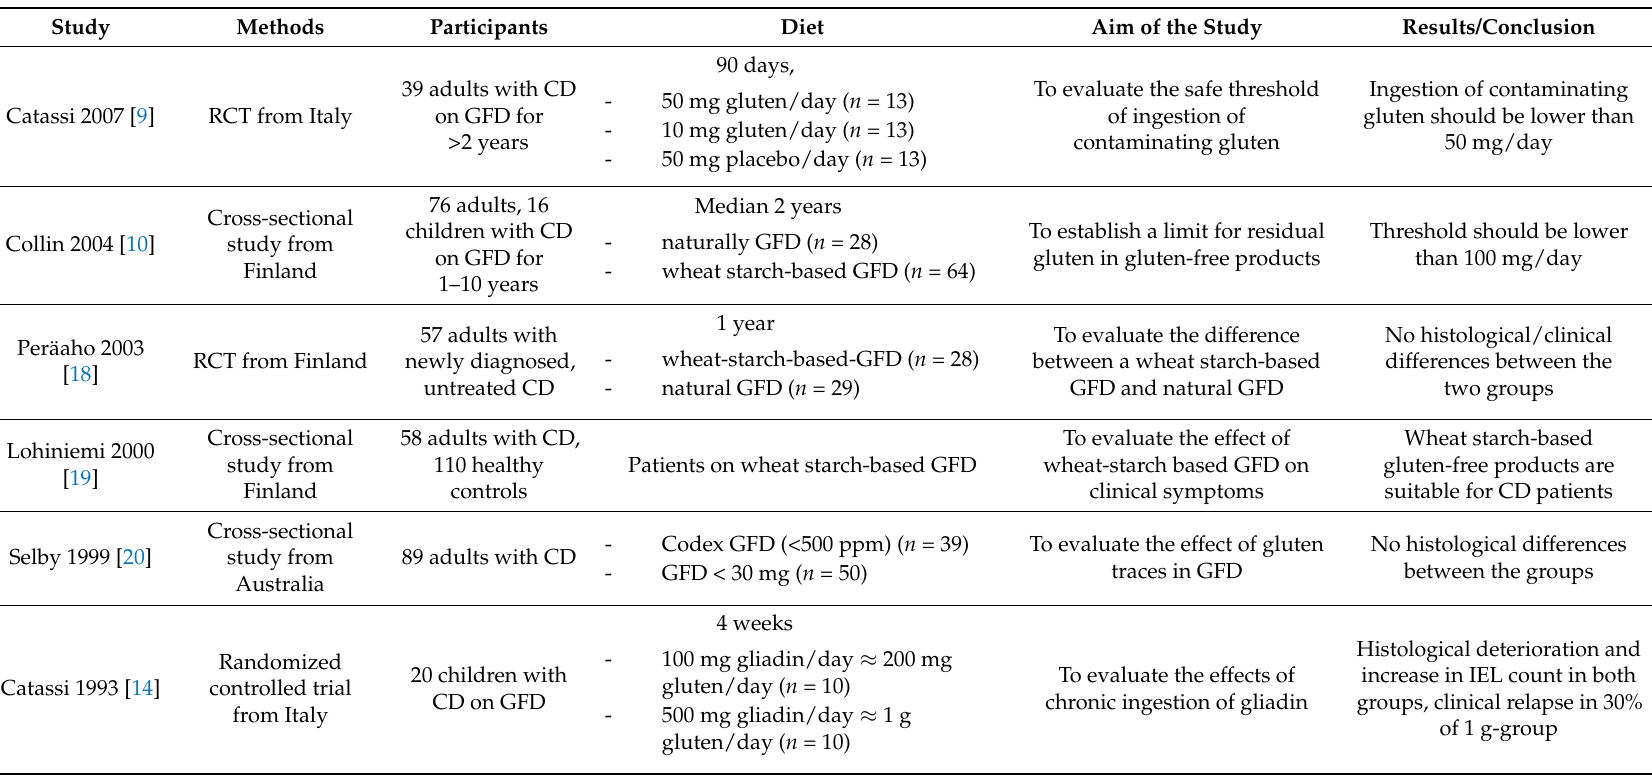
Table 2. Relevant original studies evaluating the safe daily gluten threshold for celiac disease patients (adapted from Akobeng et al. [17]). CD: celiac disease; GFD: gluten-free diet; IEL: intraepithelial lymphocytosis; RCT: Randomized Controlled